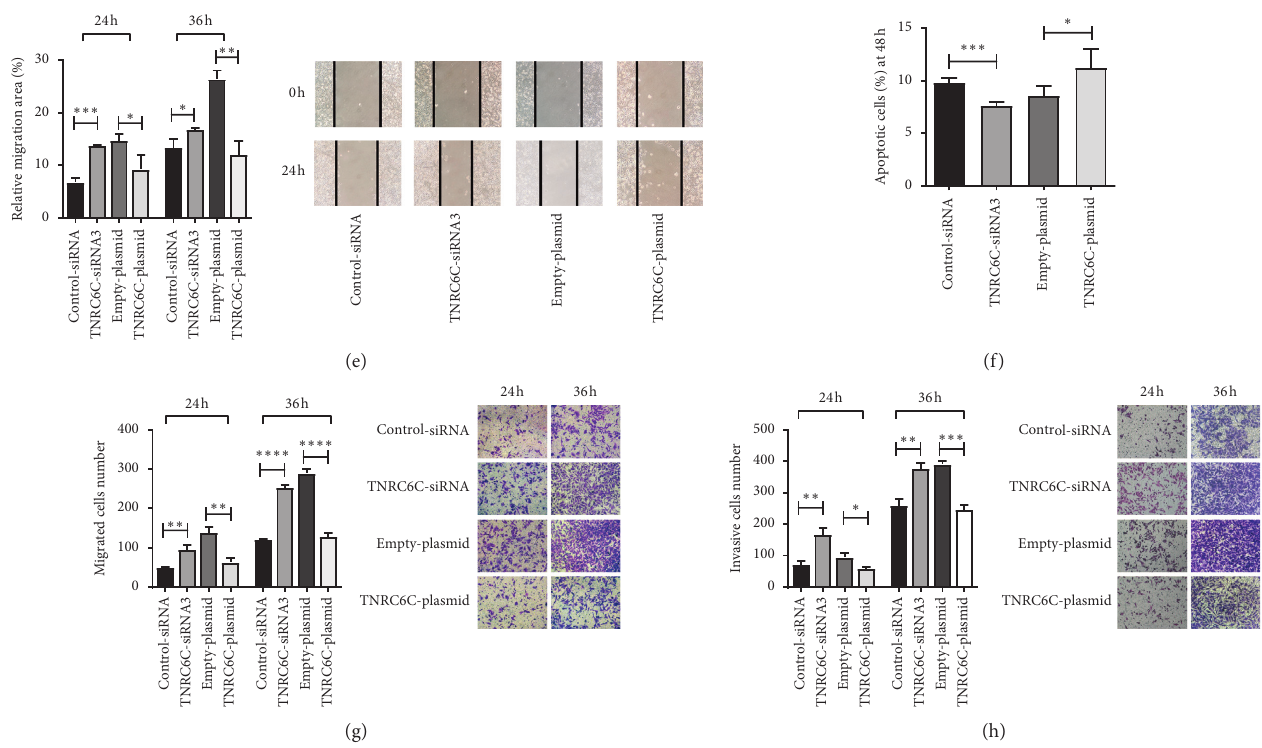
Figure 3: TNRC6C regulates the proliferation, apoptosis, migration, and invasion abilities of BCPAP cells. (a) BCPAP cells were transfected with TNRC6C-siRNA1, TNRC6C-siRNA2, TNRC6C-siRNA3, and control-SiRNA, respectively. The relative mRNA expression of TNRC6C was quantified by real-time qPCR. (b) BCPAP cells were transfected with pcDNA3.1-TNRC6C plasmid and pcDNA3.1-empty plasmid, respectively. The relative mRNA expression of TNRC6C was quantified by real-time qPCR. (c) Growth curve of BCPAP cells determined by CCK8 assay after transfection with TNRC6C-SiRNA3 or control-SiRNA. (d) Growth curve of BCPAP cells determined by CCK8 assays after transfection with pcDNA3.1-TNRC6C plasmid or pcDNA3.1-empty plasmid. (e) The effect of TNRC6C knockdown or overexpression on the migration of BCPAP cells was assessed using wound-healing assay. Quantitative analysis (left) and representative images (right). (f) The effect of TNRC6C knockdown or overexpression on BCPAP cell apoptosis was determined by flow cytometry assay. (g) The effect of TNRC6C knockdown or overexpression on the migration of BCPAP cells was assessed using transwell migration assay. Quantitative analysis (left) and representative images (right). (h) The effect of TNRC6C knockdown or overexpression on the invasion of BCPAP cells was assessed using transwell invasion assays (quantitative analysis (left) and representative images (right). Values represent the mean ± SD from three independent experiments; empty-plasmid, pcDNA3.1-empty plasmid; TNRC6C-plasmid, pcDNA3.1-TNRC6C plasmid; ∗ P < 0 . 05; ∗∗ P < 0 . 01; ∗∗∗ P < 0 . 001; ∗∗∗∗ P < 0 . 0001.